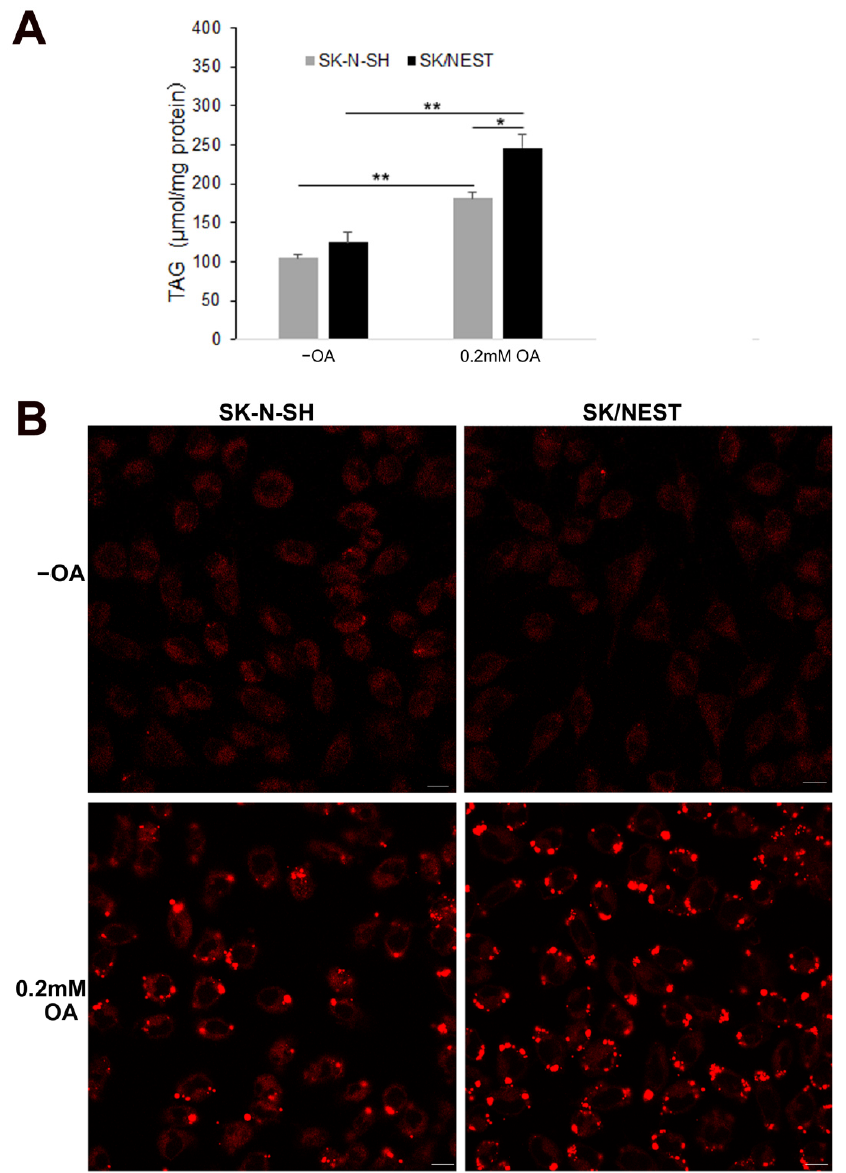
Figure 4. Overexpression of NEST promoted TG accumulation in human neuroblastoma cells. ( A ) TG levels were quantified in control cells (SK-N-SH) and NEST-expressing cells (SK/NEST) in the presence of 0.2 mM OA for 12 h or not ( − OA). Data are presented as means ± SD. Asterisks indicate p values: * p < 0.05, ** p < 0.01, n = 5. ( B ) LDs were stained with HSC LipidTOXTM Deep Red neutral lipid stain and visualized by confocal fluorescence microscopy. Figures are representative of at least three experiments. Scale bars, 20 μ m.